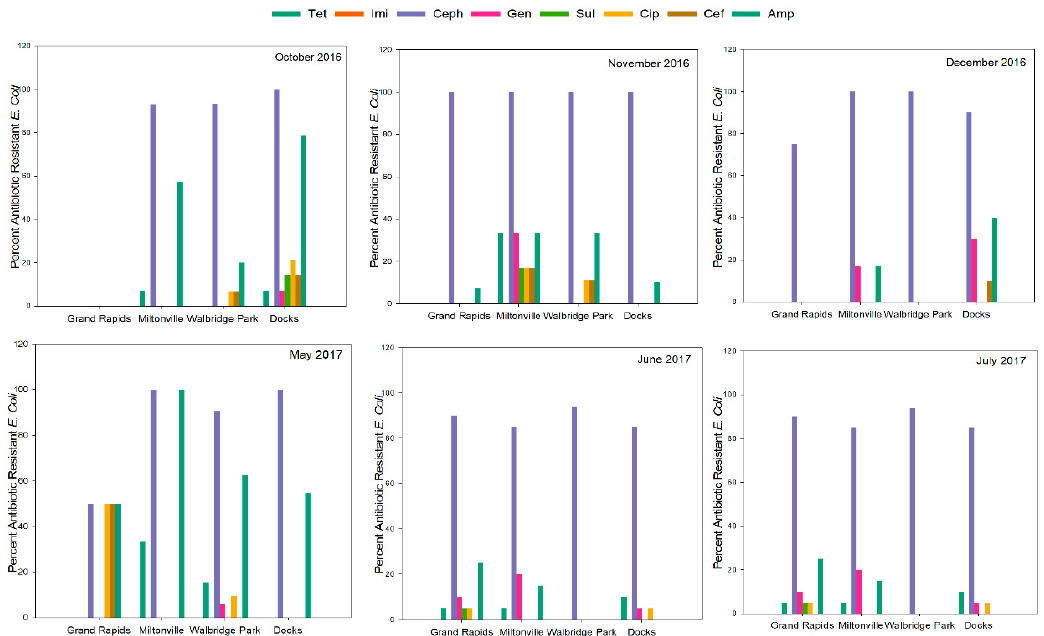
Figure 3. Percentage of antimicrobial resistance (AMR) within E. coli isolates in the four sites across all sampling events. Tet—Tetracycline, Ceph—Cephalothin, Sul—Sulfamethoxazole, Cef—Cefoperazone, Amp—Ampicillin, Cip—Ciprofloxacin, Gen—Gentamicin,